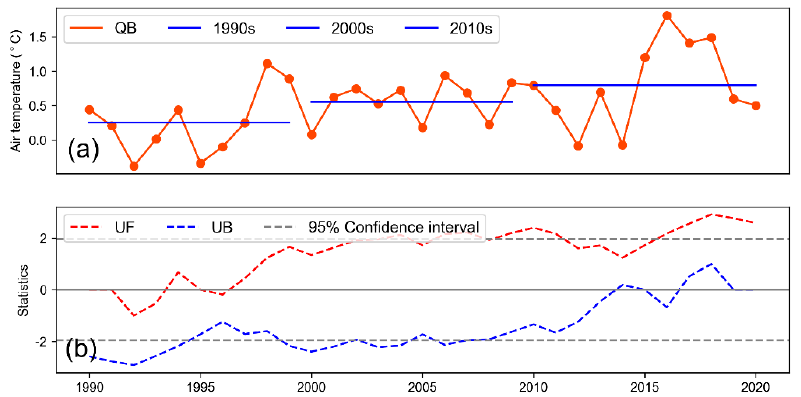
Figure 10. ( a ) Air temperature changes in the Qaidam Basin from 1990 to 2020. The blue solid line represents the decade average of the change in Evaporation. ( b ) Mann-Kendall test results of air temperature in Qaidam Basin.